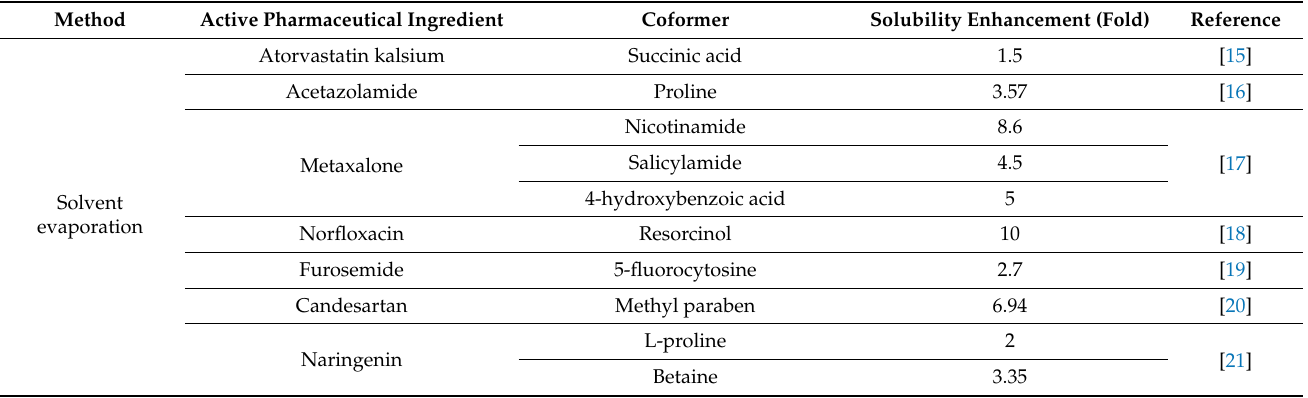
Table 1. Solubility data of multicomponent crystals of active pharmaceutical ingredients with